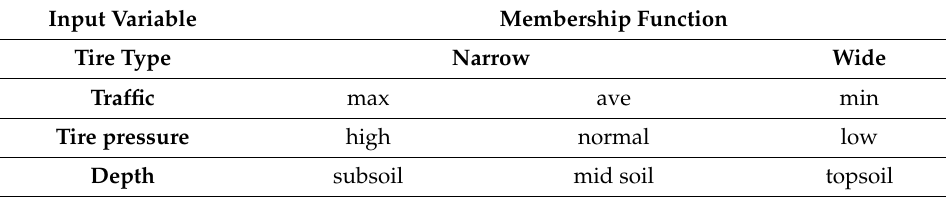
Table 1. Membership functions of input variables.